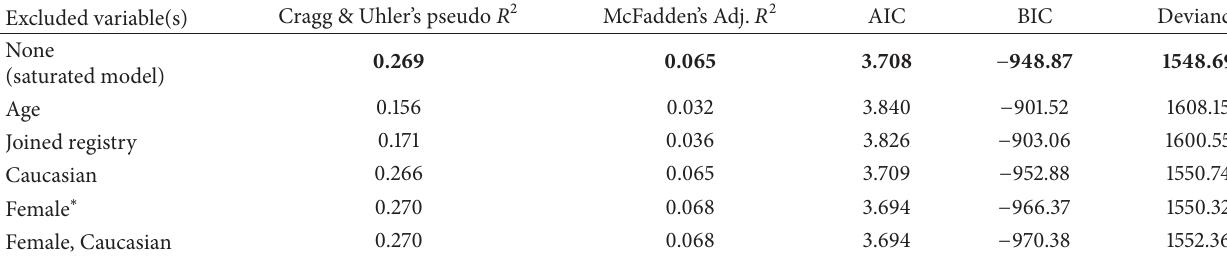
Table 7: Statistics for model fit.